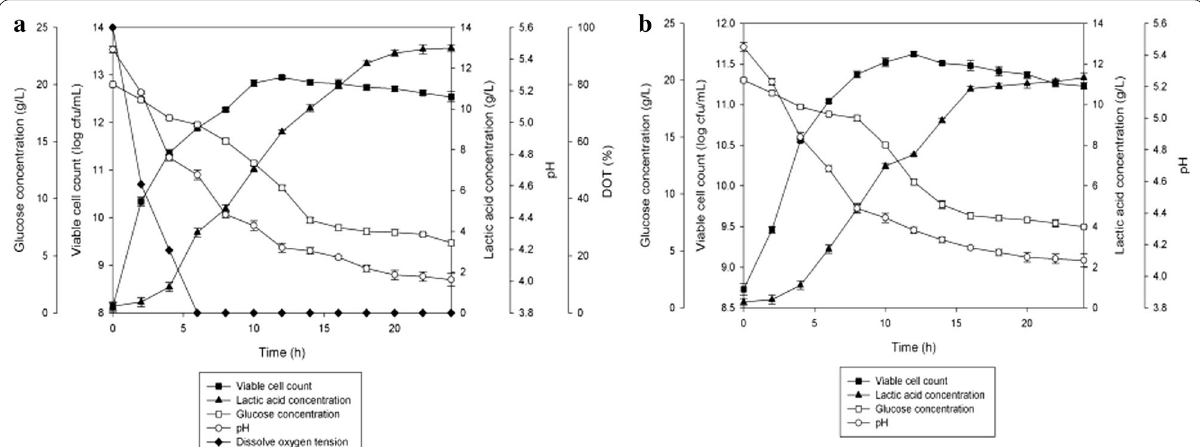
Fig. 3 The time course of batch fermentation of P. acidilactici in 2 L stirred tank bioreactor at condition of a facultative, b anaerobic. The fermenta- tion was conducted at 300 rpm. The error bars represent the standard deviations about the mean (n